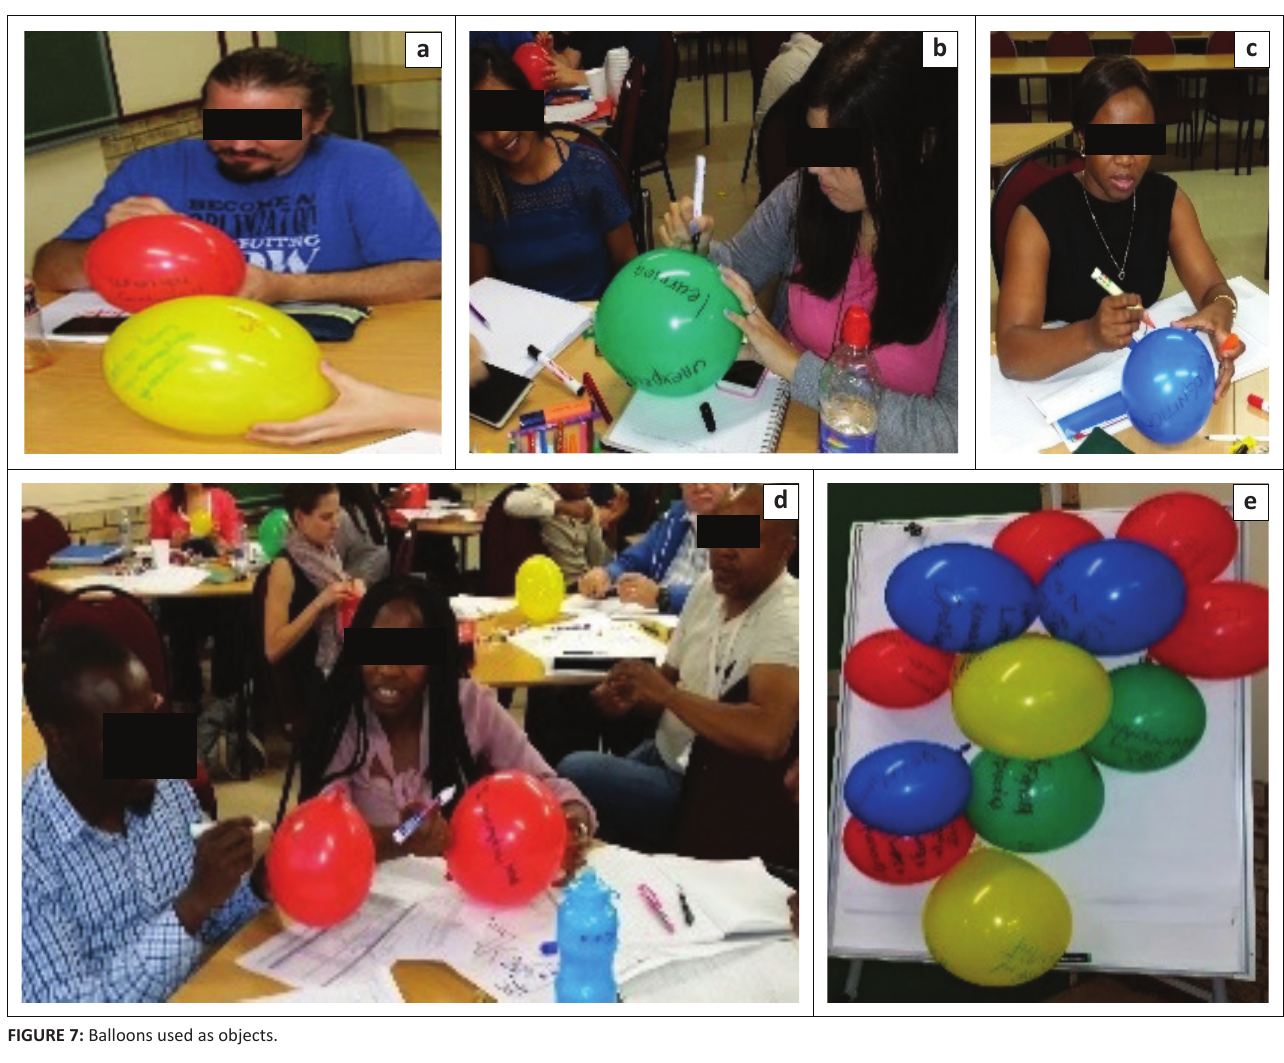
FIGURE 7: Balloons used as